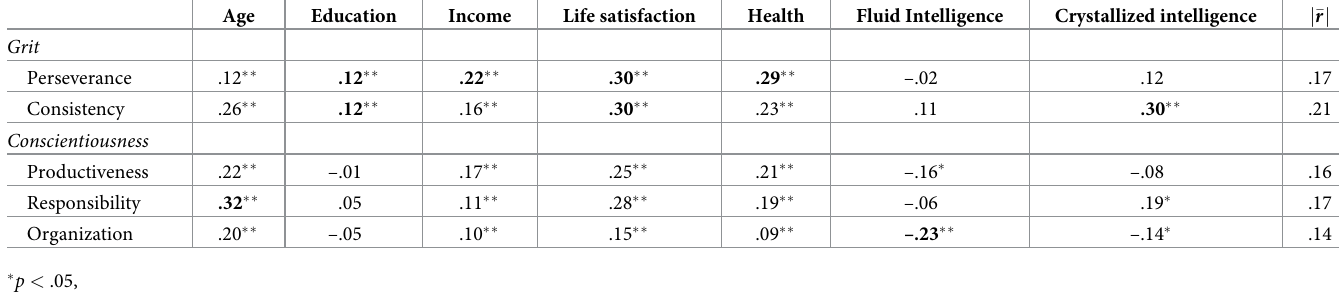
Table 4. Correlations of the facets of Grit and Conscientiousness with age, education, income, life satisfaction, health, and fluid and crystallized intelligence from Model A (correlated first-order facet